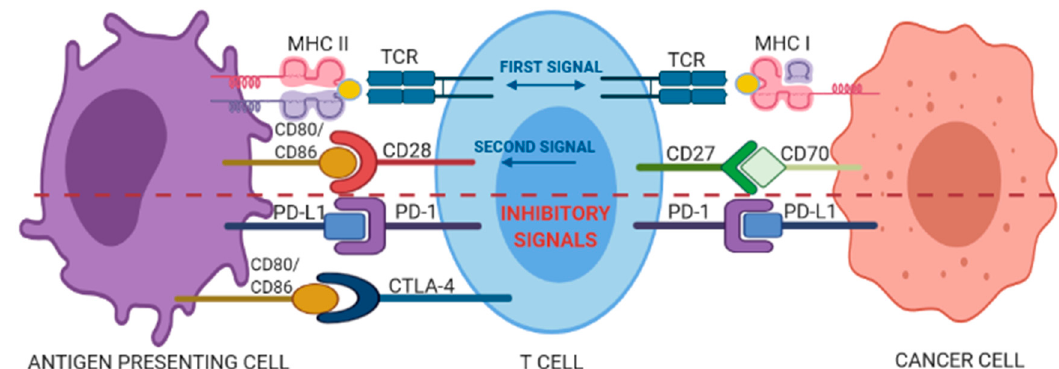
Figure 1. Interplay between co-stimulatory and inhibitory signals of a T-cell interacting with an antigen presenting cell (APC) or a cancer cell. See text for details.